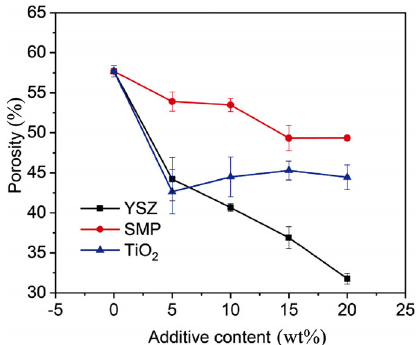
Fig. 4 Effects of the additive contents on the porosity of the mullite hollow fiber membranes sintered at 1570 ℃